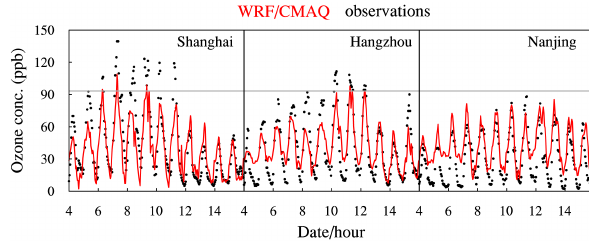
Figure 6. Hourly variations of the observed and the simulated O 3 concentrations in Shanghai, Nanjing and Hangzhou during 4 to 15 August 2013. The red solid lines show the modeling results, the black dot lines give the observations, and the solid gray lines repre- sent the national standard for the hourly O 3 concentration, which is 200µgm − 3